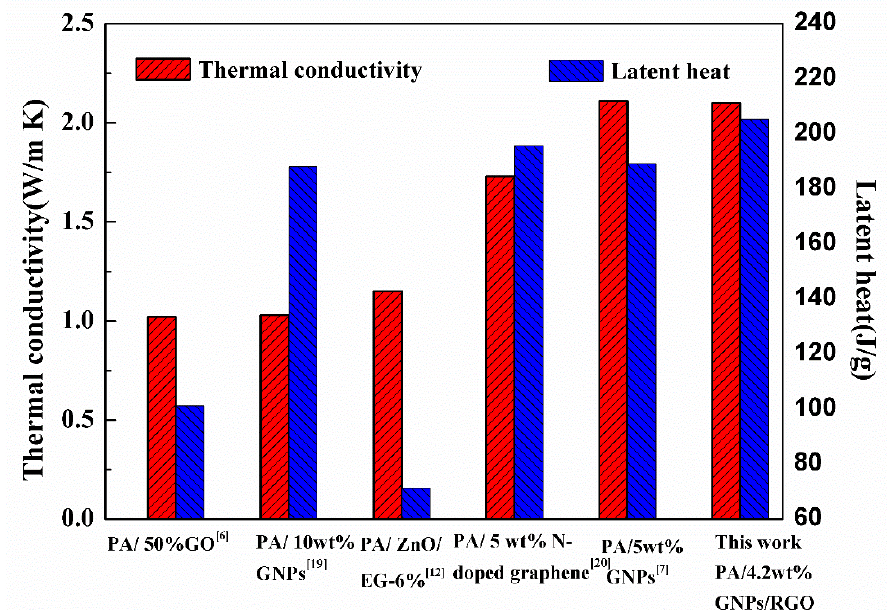
Figure 8. Thermal conductivity and latent heat of PA-based composites in the literature [6,7,12,19,20].